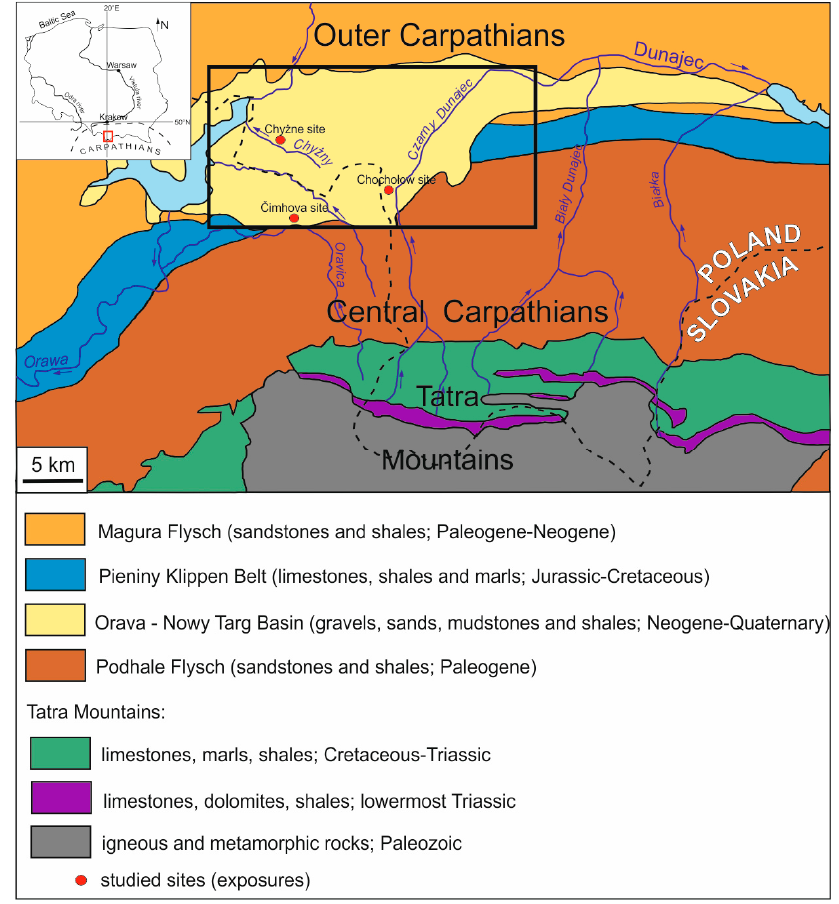
Figure 2. Geological sketch-map of the Orava-Nowy Targ Basin with studied sites, after Tokarski et al.